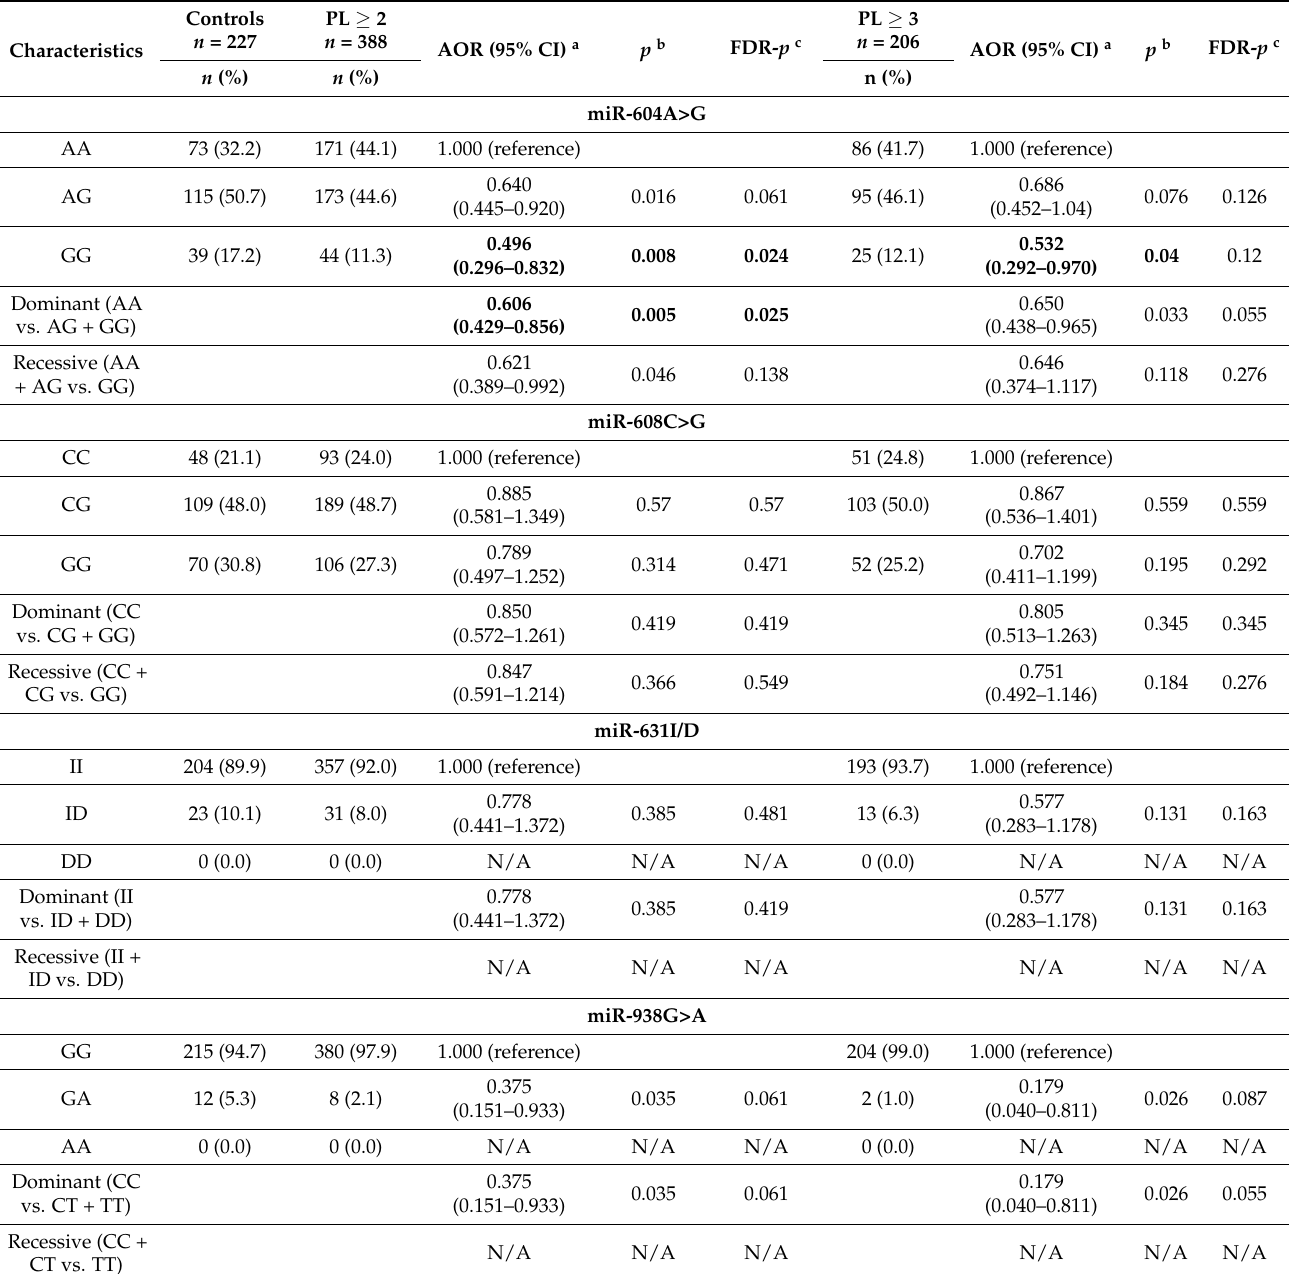
Table 2. Comparison of microRNA polymorphic genotype frequencies in controls and RPL